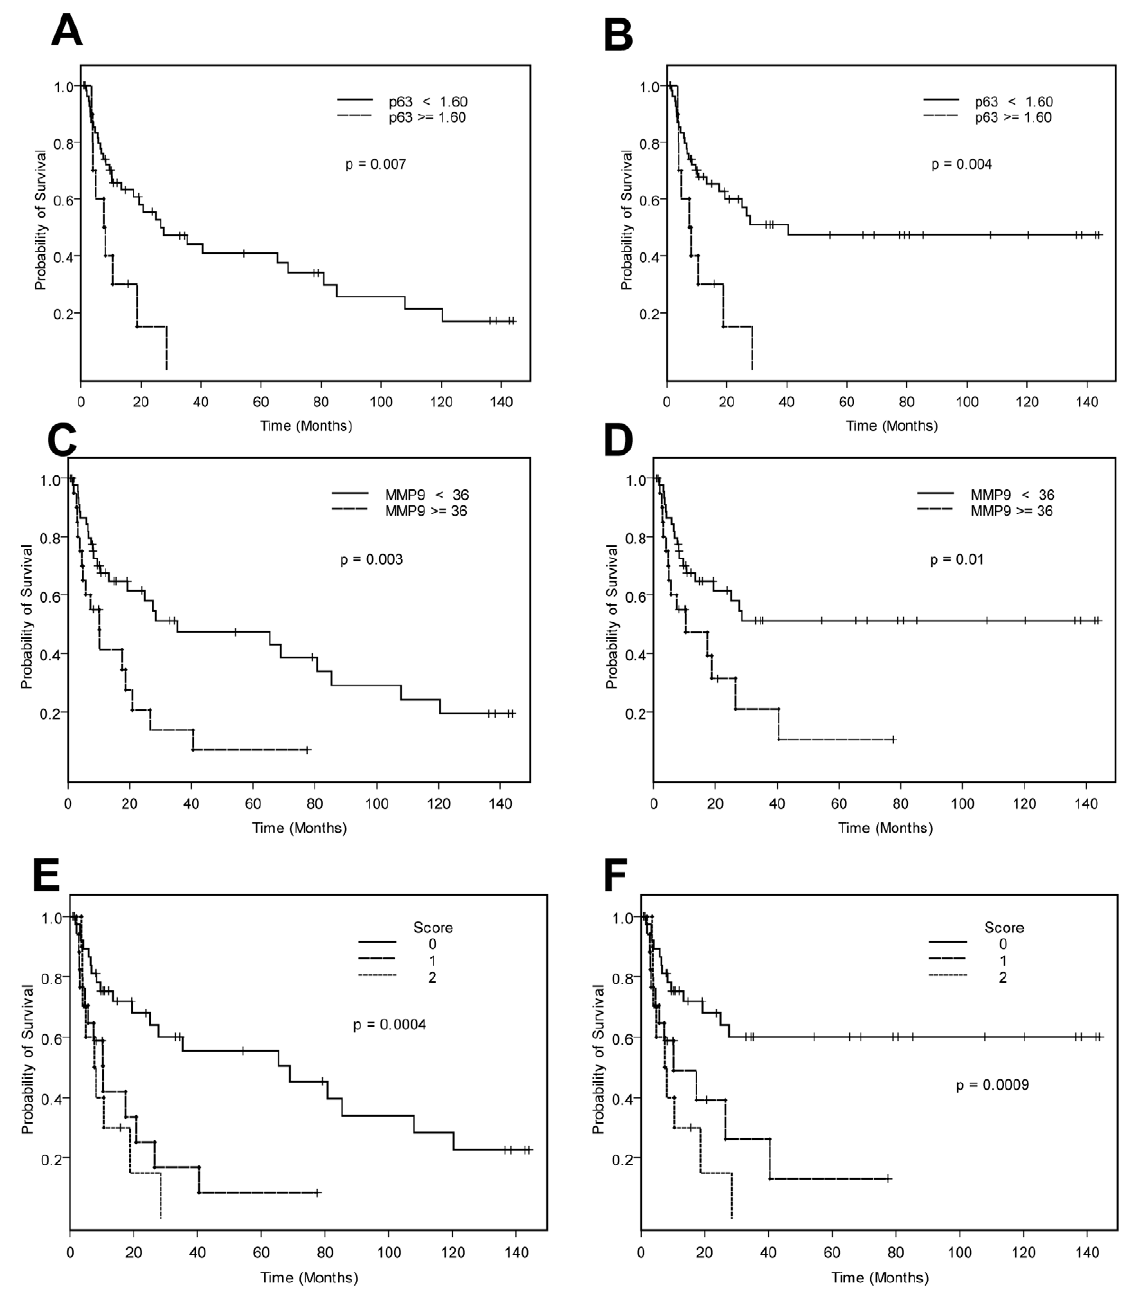
Figure 4. Kaplan-meier overall survival (OS) and disease-specific survival (DSS) curves based upon RT-PCR data for p63 and MMP9 in the subset of invasive tumors. All p-values provided are 2-sided, using the log-rank test. A: Elevated p63 was associated with adverse outcome in patients with muscle-invasive cancer (median OS 8 months, 95% confidence interval 4, 140 months), as compare to lower expression of p63 (median OS 27 months, 95% CI of 17, 85 months) log-rank p=0.007. B: Elevated p63 was associated with adverse DSS in patients with muscle-invasive cancer (median DSS 8 months, 95% CI 19, 140), whereas patients with lower levels of p63 had an improved median DSS of 41 months (95% CI 19, 140 + months, log-rank p=0.004). C: Elevated MMP9 was associated with adverse outcome (median OS 10.2 months, 95% CI i4.9, 26.6) as compared to lower MMP9 (median OS 35.4 months, 95% CI 19.3, 107.9, p=0.003). D: Elevated MMP9 was associated with adverse DSS (median 10.3 months, 95% CI: 4.9, 140 + ) as compared to lower MMP9 (median DSS . 140, 95% CI: 19.3, 140 + months, p=0.01). E (OS) and F (DSS): Using a multivariate Cox regression model, p63 and MMP9 were independent predictors for adverse outcome in muscle-invasive disease. Patients were assigned 1 point each for either elevated p63 or MMP9 (0=neither elevated, 1=either elevated, 2=both elevated). Worst survival was observed when both markers were elevated, and best when neither was elevated (median OS for 0, 1, or 2: . =69, 10 months, and 8 months, with a 5-year OS or 55%, 8%, and 0% respectively).